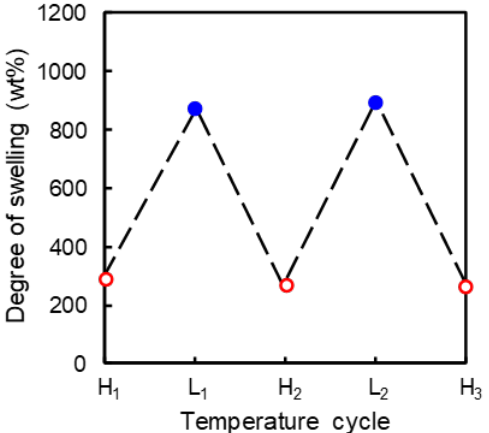
Figure 6. Reversibility of the degree of swelling of P1b-gel after soaking in chloroform at 45 °C for − 30 ◦ C for 24 h (Ln, blue solid 24 h (Hn, red open circle) and at −30 °C for 24 h (Ln, blue solid circle). 24 h (Hn, red open circle) and at